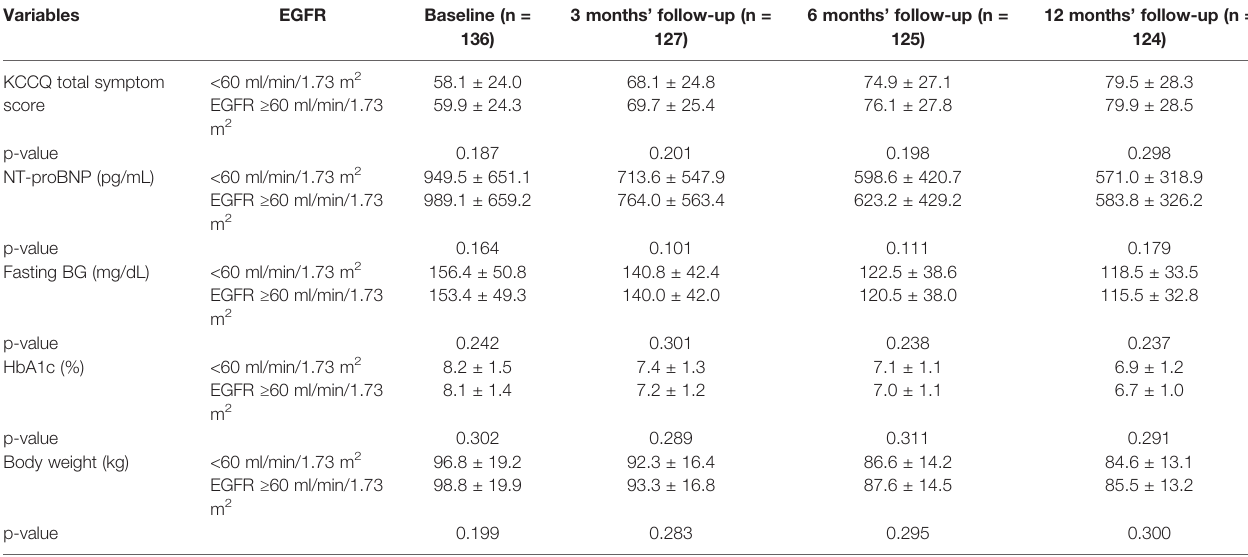
TABLE 3 | Kansas City Cardiomyopathy Questionnaire total symptom score, N-terminal pro-brain natriuretic peptide levels, fasting blood glucose, glycated hemoglobin, and body weight according to estimated glomerular fi ltration